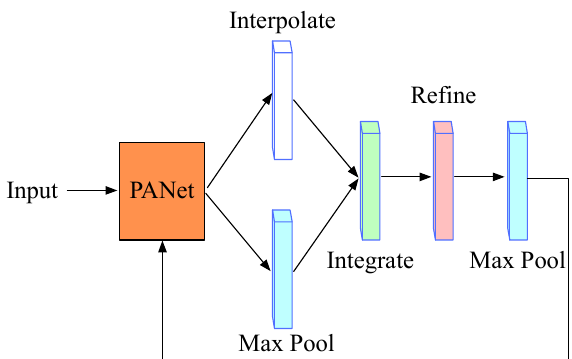
Figure 5. Architecture of the refined branch.